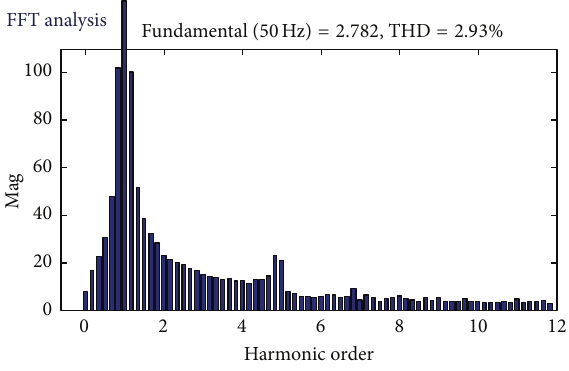
Three-phase resistive loads are switched in at different instants; three-phase loads of 1 kW, 2.5 kW, and 1 kW, respec- tively, are connected and then disconnected at 1.0 s and 1.5 s,